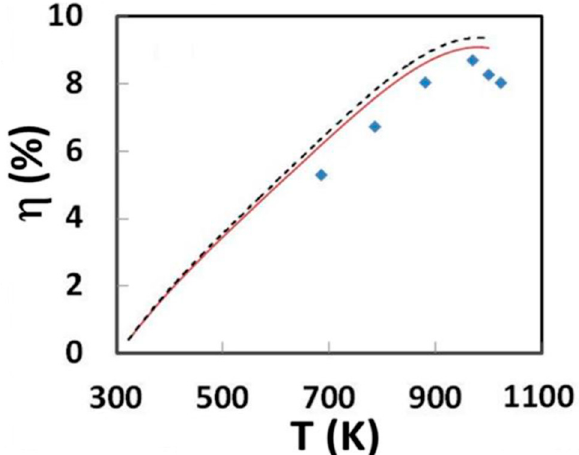
Figure 1. Thermoelectric (TE) conversion efficiency for n-p couple built using Hf 0.6 Zr 0.4 NiSn 0.995 Sb 0.005 (n-type) and Hf 0.3 Zr 0.7 CoSn 0.3 Sb 0.7 /nano-ZrO 2 (p-type). Plots: measurement (cyan rhombus), calculation using temperature-averaged zT (dashed line), calculation using temperature-dependent parameters in Reference [12] (solid line). Table 2. Thermoelectric conversion efficiency and power density of n-p couple and unileg devices. zT values of the n and p legs are also included. ∆ T is the temperature difference between the hot and cold ends. Data are extracted from the references. Unpublished results are